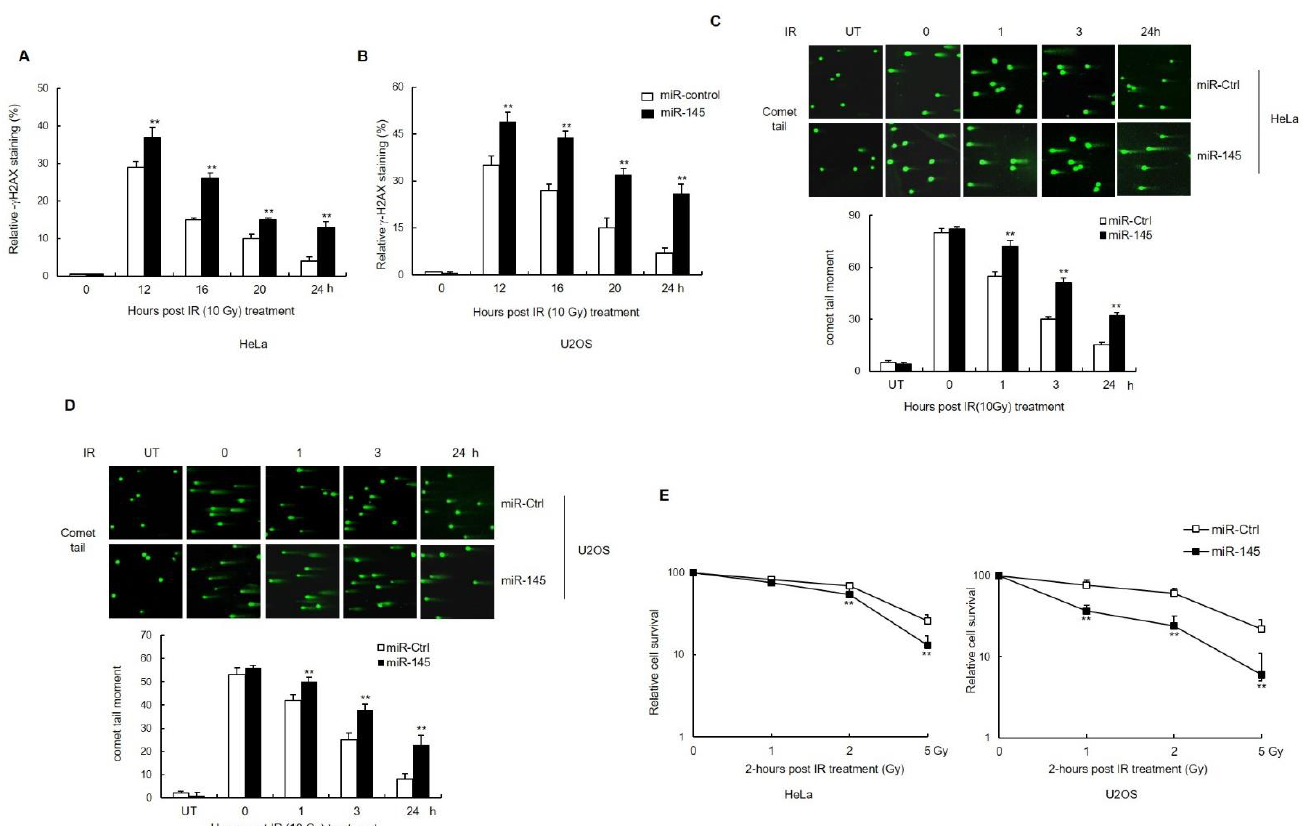
Figure 3. Effect of miR-145 overexpression on DNA repair and cell radiosensitivity. ( A , B ) HeLa ( A ) and U2OS ( B ) cells transfected with either miR-145 or miR-Ctrl were irradiated with 10 Gy and then fixed for immunofluorescence staining of γ -H2AX at the indicated time points. The percentage of γ -H2AX foci-stained cells was calculated. ( C , D ) HeLa ( C ) and U2OS ( D ) cells transfected with either miR-145 or miR-Ctrl were irradiated with 10 Gy and then subjected to a neutral comet assay at the indicated time points. Representative blots are shown. The comet tail moment was counted, and approximately 100 cells were analyzed in each group. ( E , F ) HeLa ( E ) and U2OS ( F ) cells transfected with miR-145 or a control miRNA were irradiated with γ -ray at indicated doses, seeded onto dishes, and grown for 2 – 3 weeks. Viability of treated cells was examined using the clonogenic survival assay. In all panels, mean ± SD is shown. **, p < 0.01 versus control group. IR: irradiation.